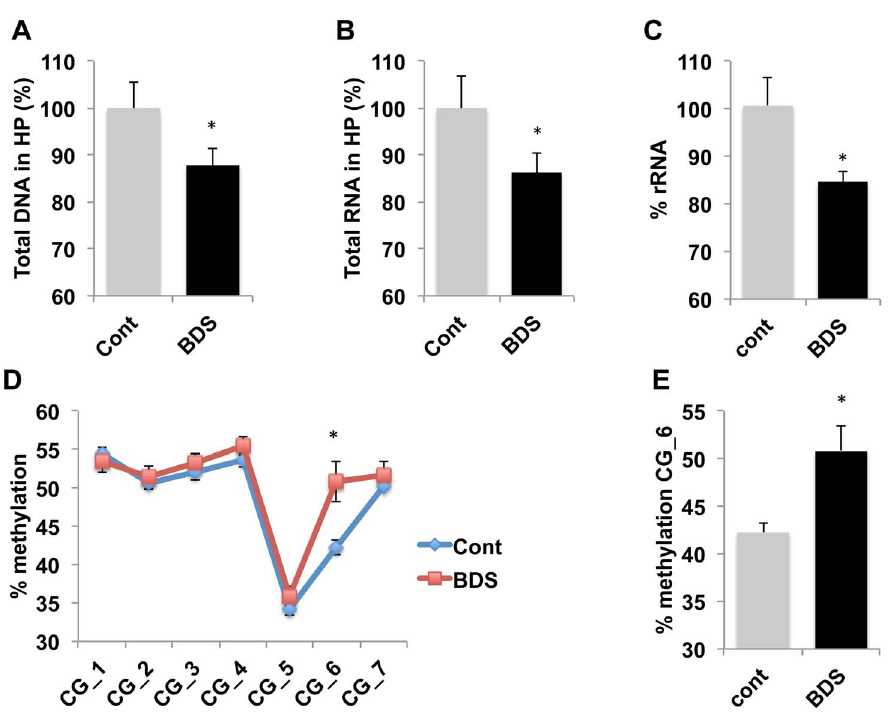
Fig. 3. Exposure to BDS decreases rRNA levels and increases DNA methylation at the rDNA promoter of 14-day old pups. Exposure to BDS decreases total amount of DNA (A) and RNA (B) harvested from the hippocampus of 14-day old pups. C. Relative levels of rRNA are lower in BDS compared to control 14-d old pups. Exposure to BDS increases DNA methylation at CG_6 (D and E). Unpaired Student t tests (A, B, C, E), Repeated measures ANOVA followed by simple-effect analysis (D). Error bars represent mean ¡ SEM, *p , 0.05.